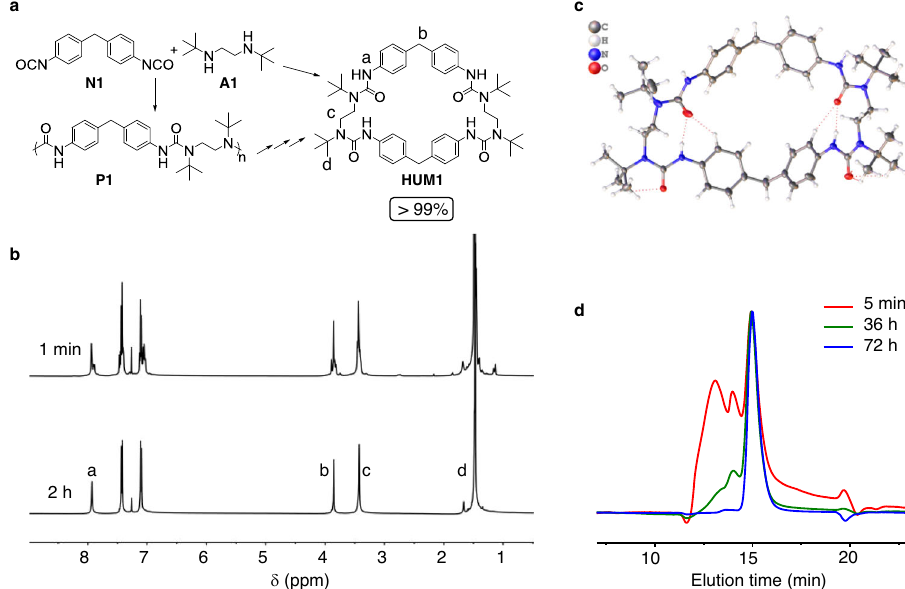
Fig. 2 Quantitative synthesis of the hindered urea macrocycle HUM1. a Structures of N1 , A1 , their corresponding oligomer P1 and the dimeric macrocycle HUM1 . b 1 H NMR of the 1:1 mixture of N1 and A1 (50 mM) upon mixing and after 2 h incubation at 60 °C in CDCl 3 . The sharp and clean peaks demonstrated near quantitative yield of HUM1 . c Single-crystal structure of HUM1 . Color code: gray, C; white, H; blue, N; red, O. d Normalized GPC trace showing the formation process of HUM1 (200 mM in chloroform, 20 °C). After incubation, broad and multimodal peaks (red trace) gradually transformed into a sharp peak (blue trace), demonstrating the equilibration process and the near quantitative yield of HUM1